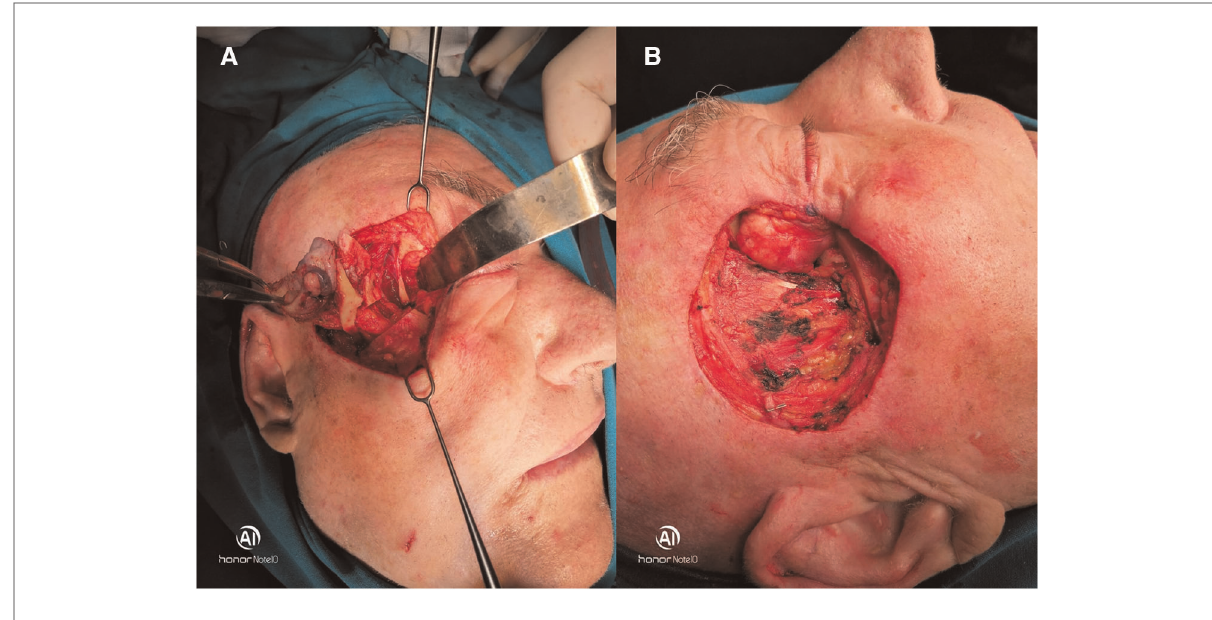
FIGURE 2 ( A,B ) Surgical approach with the resection of the lateral orbital wall and completely removed tumor with a preserved eyeball.